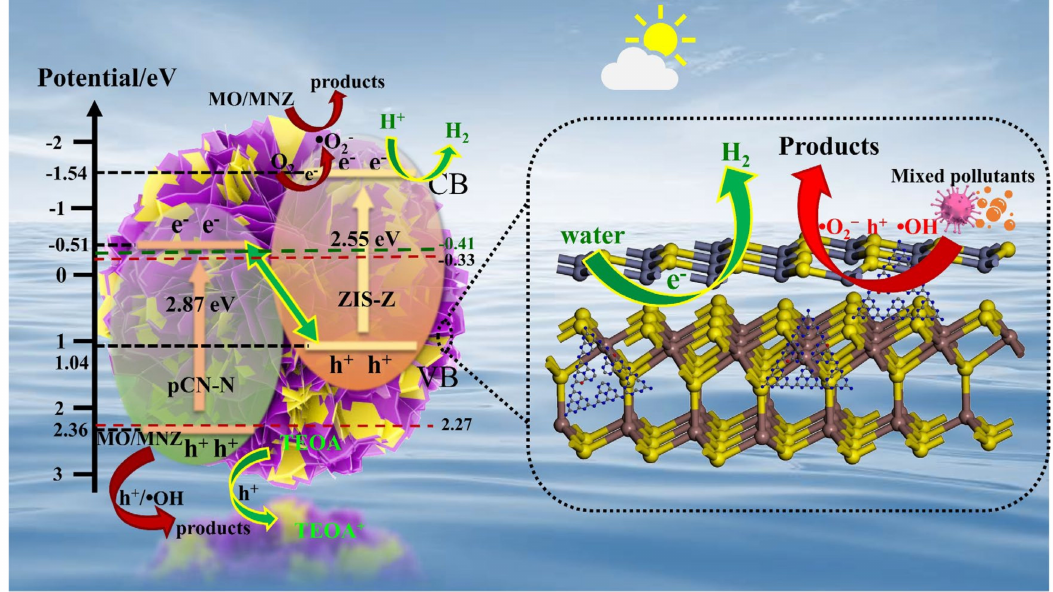
Figure 12. The possible photocatalytic mechanism of